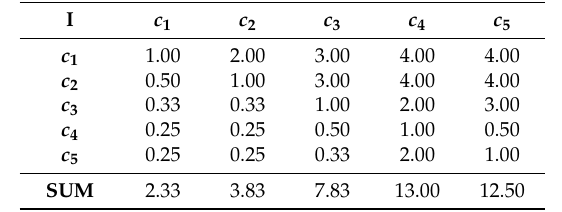
Pairwise comparison matrix of the criteria C , for the specific case of GEOTeCH integrated technologies.